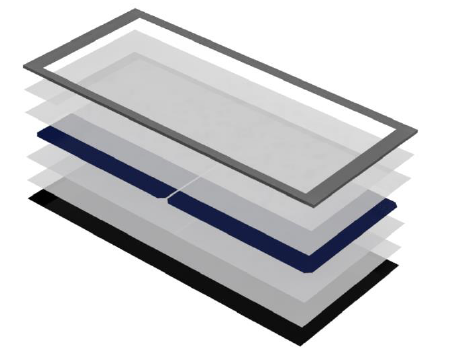
Fig. 6. Micromodule 2 cells 125·125 mm proposed by Electrotile